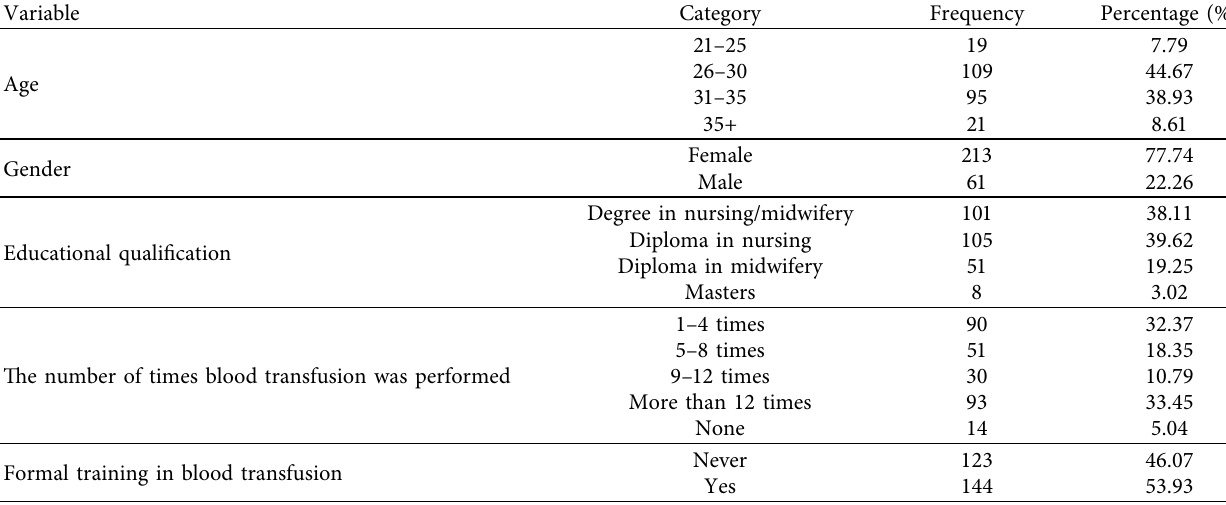
Table 1: Demographic characteristics.